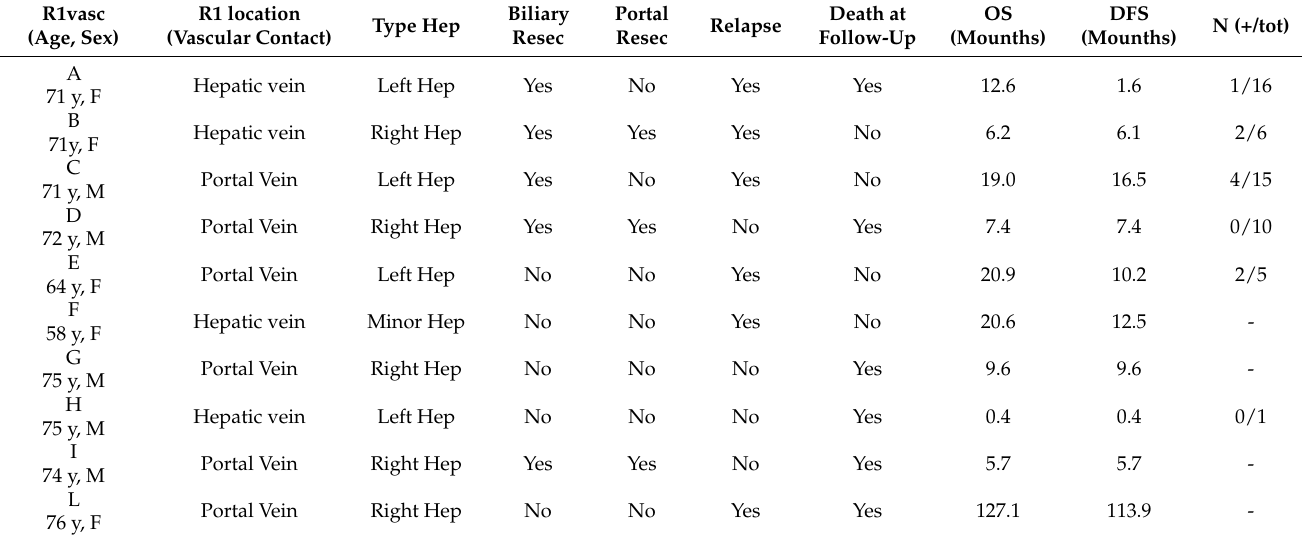
Table 3. Clinical and surgical features of the R1vasc